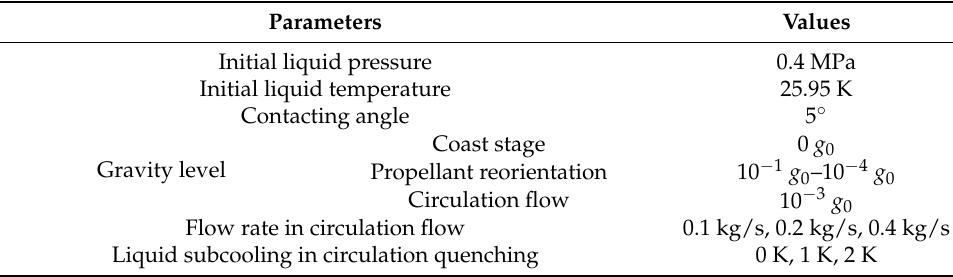
Table 2. Initial and boundary parameters in the present CFD